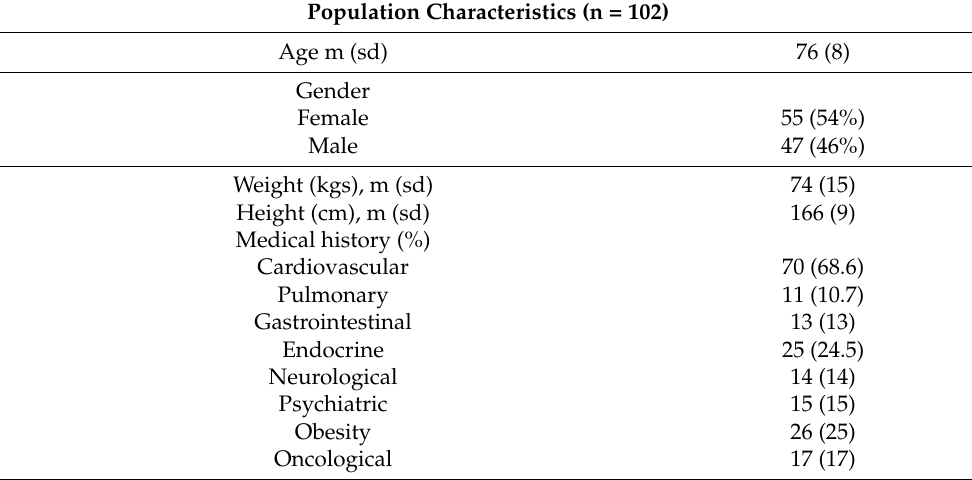
Table 3. Description of the